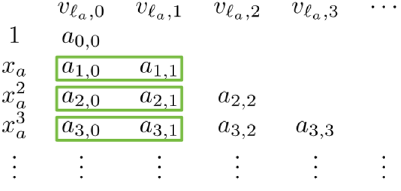
. For a fixed column (fixed q ), the purple a . ‘ a ,q